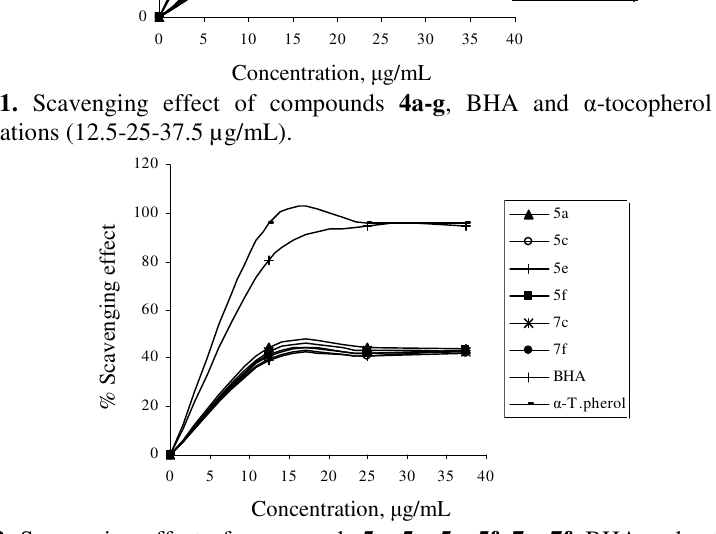
Figure 2. Scavenging effect of compounds 5a, 5c, 5e, 5f, 7c, 7f , BHA and α -tocopherol at different concentrations (12.5-25-37.5